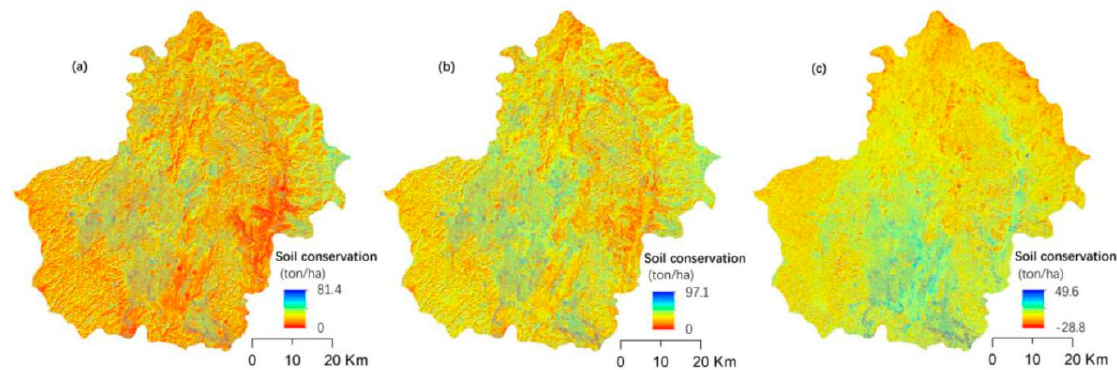
Figure 3. Spatial distribution of soil conservation and its change in Huanjiang County. ( a ) The distribution of soil conservation in 2005; ( b ) The distribution of soil conservation in 2015; ( c ) the changes of soil conservation from 2005 to 2015.